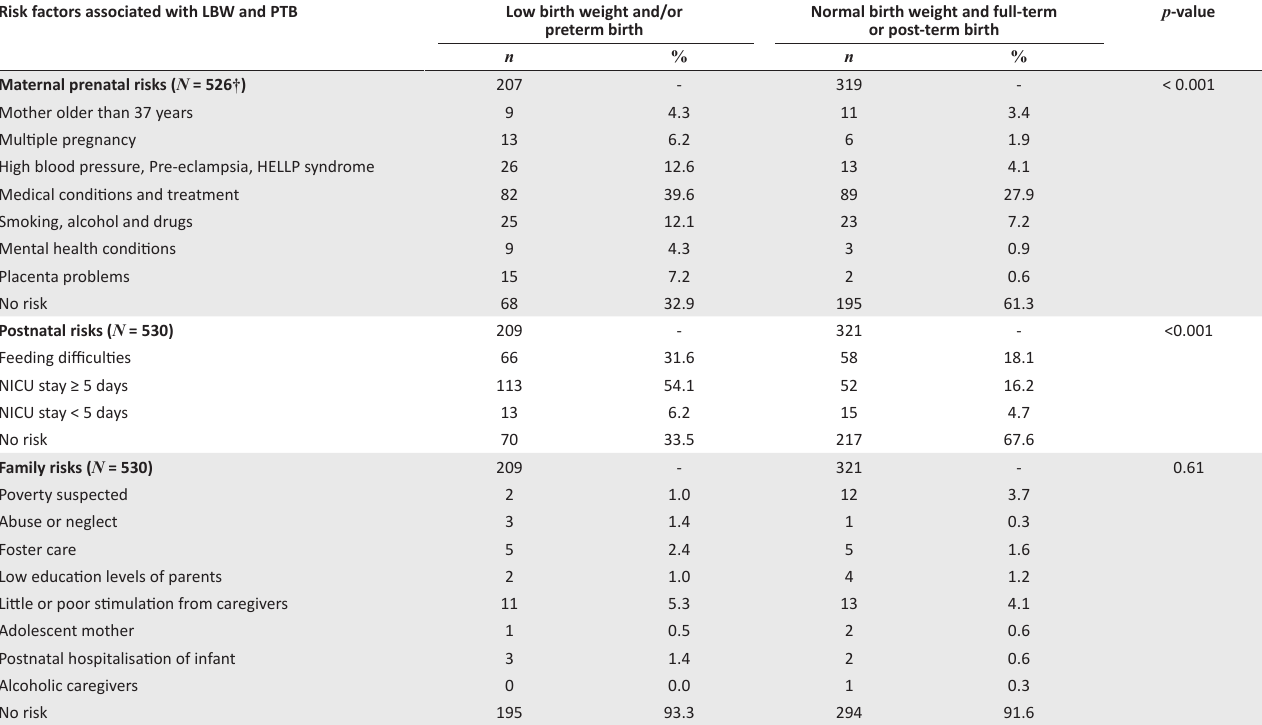
TABLE 7: Prenatal, postnatal and environmental risks associated with low birth weight and preterm birth. Risk factors associated with LBW and PTB Low birth weight and/or